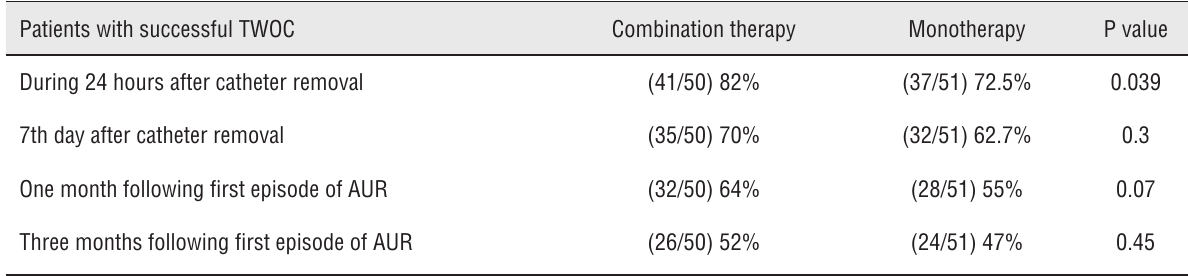
Table 1 - Three month follow-up period of patients after the first episode of spontaneous AUR. Patients with successful TWOC Combination therapy